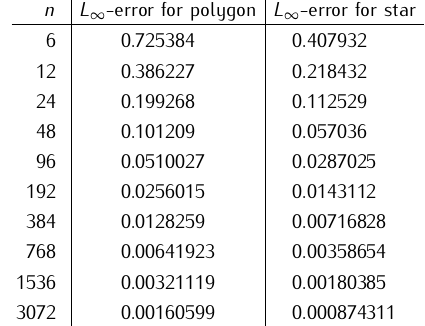
Table 1. Third example: comparison of the relative L